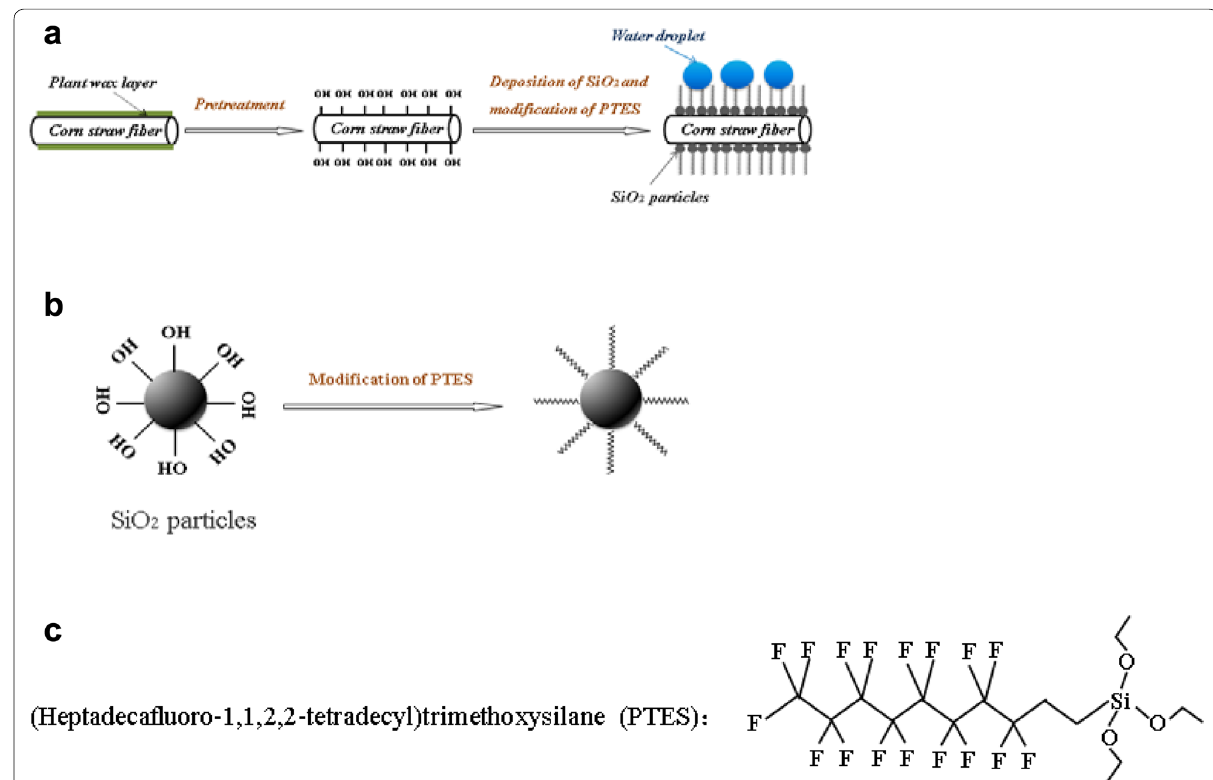
Fig. 1 a Synthesis of superhydrophobic/superoleophilic corn straw and a water droplet on the resulting corn straw fiber surface. b Schematic illustration for the modification of SiO 2 particles with PTES. c Chemical structure of (Heptadecafluoro‑1,1,2,2‑tetradecyl) trimethoxysilane